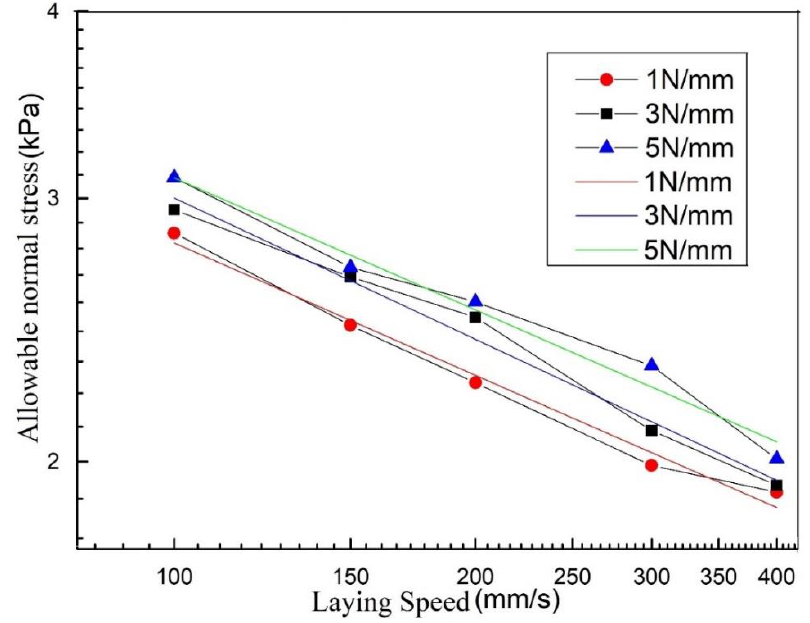
Figure 18. Laying speed/allowable normal stress logarithmic curve of prepreg/prepreg laminate.